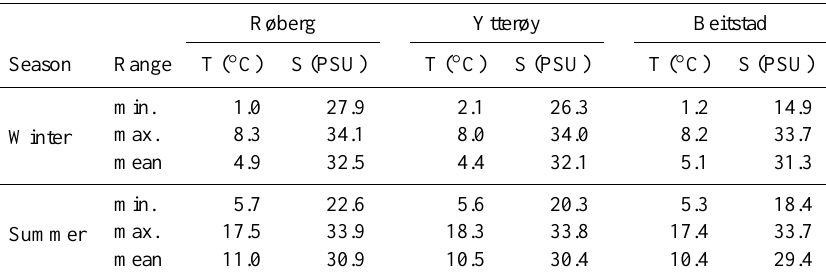
Table 1. Minimum, maximum and mean winter and summer temperatures and salinites of surface waters at the mooring stations Røberg, Ytterøy and Beitstad from 1963 to 2005 (Trondheim Biological Station/NTNU Trondheim: http://www.ntnu.edu) Røberg Ytterøy Beitstad Season Range T ( ◦ C) S (PSU) T ( ◦ C) S (PSU) T ( ◦ C) S (PSU) min. 1.0 Winter